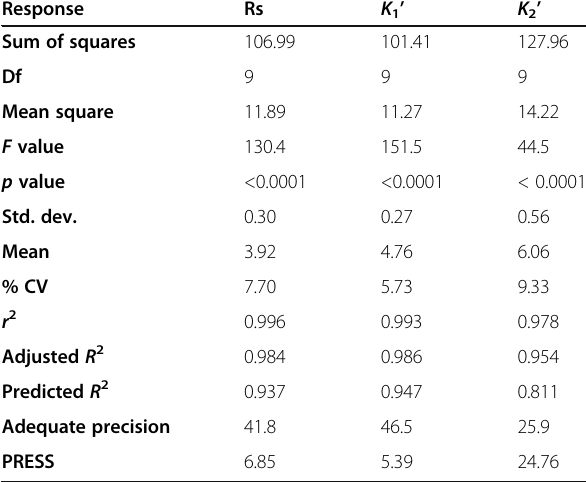
Table 2 ANOVA and regression analysis of selected